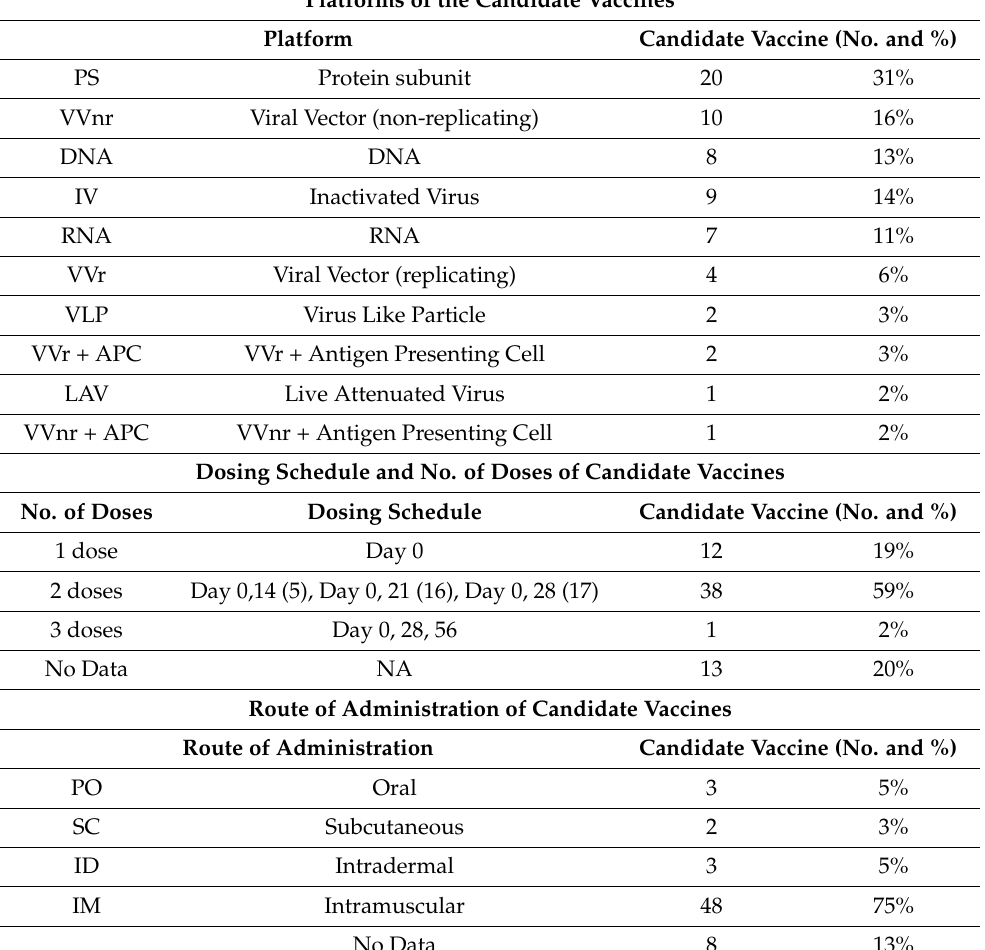
Table 2. Summary of the platforms, dosing schedule, no. of doses and route of administration of candidate vaccines in the clinical trials [2]. Platforms of the Candidate